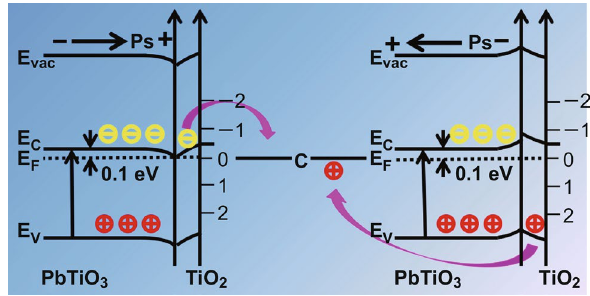
Fig. 7 Schematic of the energy level diagram for the band structure of PbTiO 3 -TiO 2 system assuming different polarization (Ps) direc- tions. E c , E v , E f , and E vac are the energies of the conduction band, val- ance band, Fermi level, and vacuum